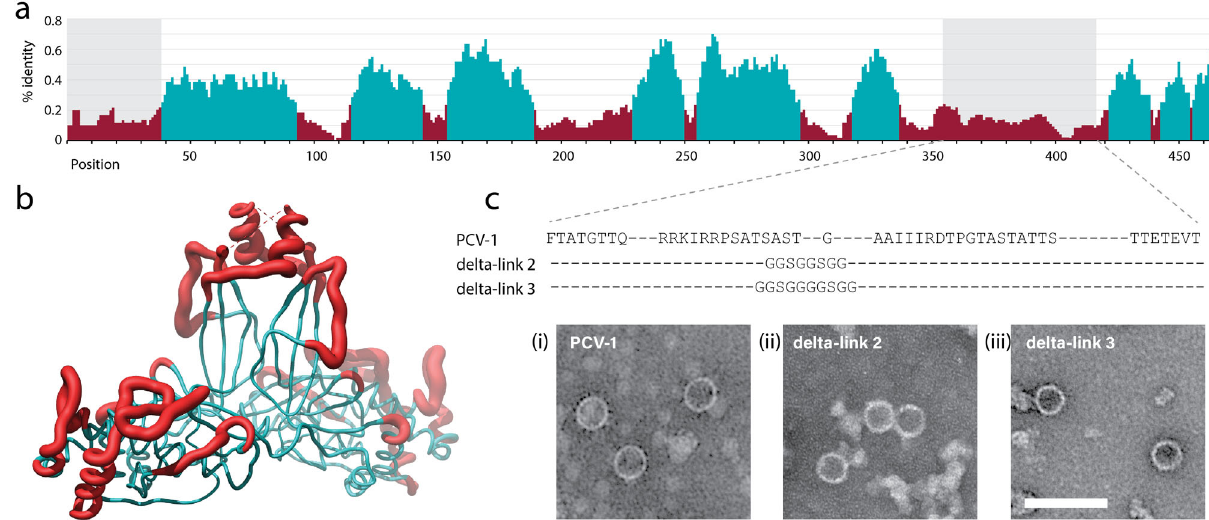
Fig. 4 The hypervariable protrusion is not required for capsid assembly. a Alignment of CP amino acid sequences of PCV-1, Pepper cryptic virus 2 (PCV- 2) and the two CP sequences identi fi ed for Beet cryptic virus 2 (BCV-2). Shaded regions correspond to the unresolved regions of PCV-1 CP and positions coloured cyan correspond to > 25% identity using a 10-position rolling average. b Map of the percentage identity from the alignment to the PCV-1 protomer structure. Cyan regions have ≥ 25% identity and red regions have < 25% identity (10-position rolling average) with grey shading indicating the missing density in the PCV-1 reconstruction. c PCV-1 CP variants with protrusion deletions and TEM images of density gradient puri fi ed particles. Images show (i) WT PCV-1 CP, and two deletions of the disordered region, replaced with short linker sequences delta-link 2 (ii) and delta-link 3 (iii). Bar = 100